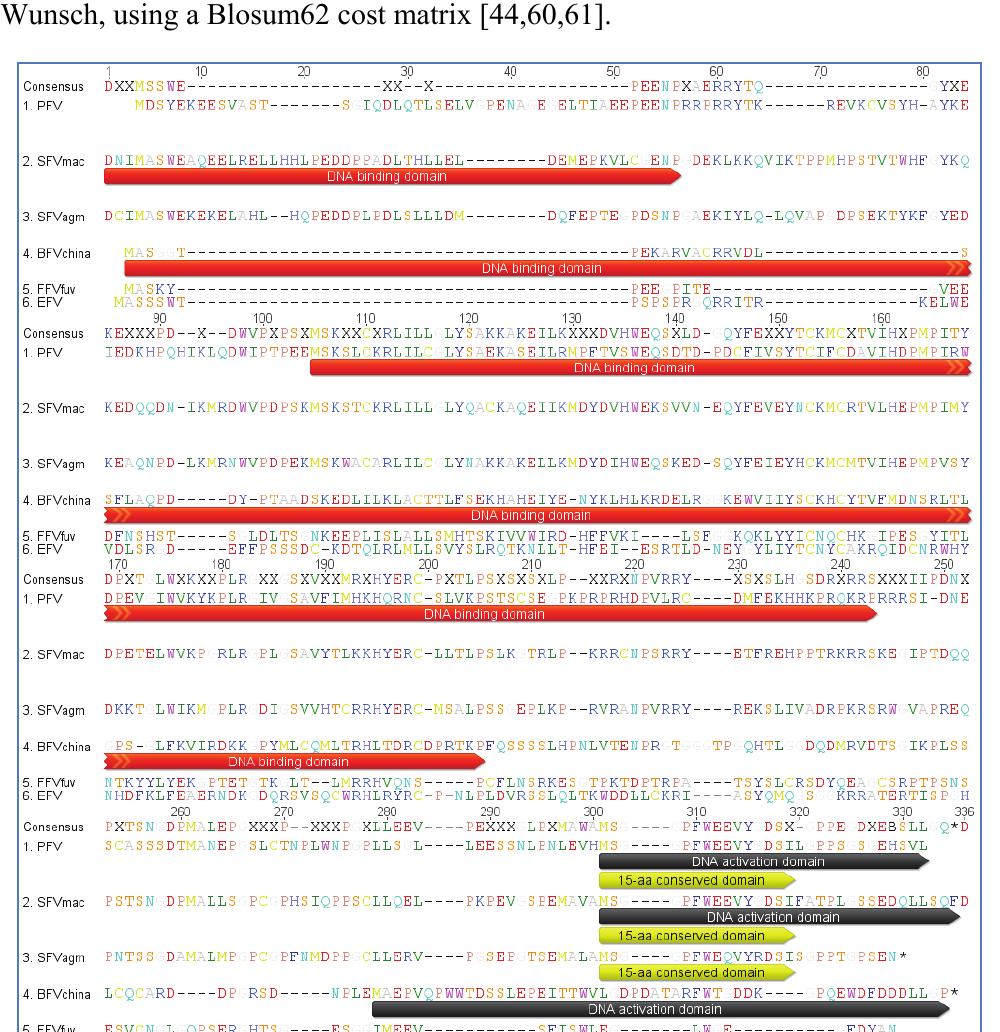
Figure 6. Protein sequence alignment of Tas sequences from PFV, SFV